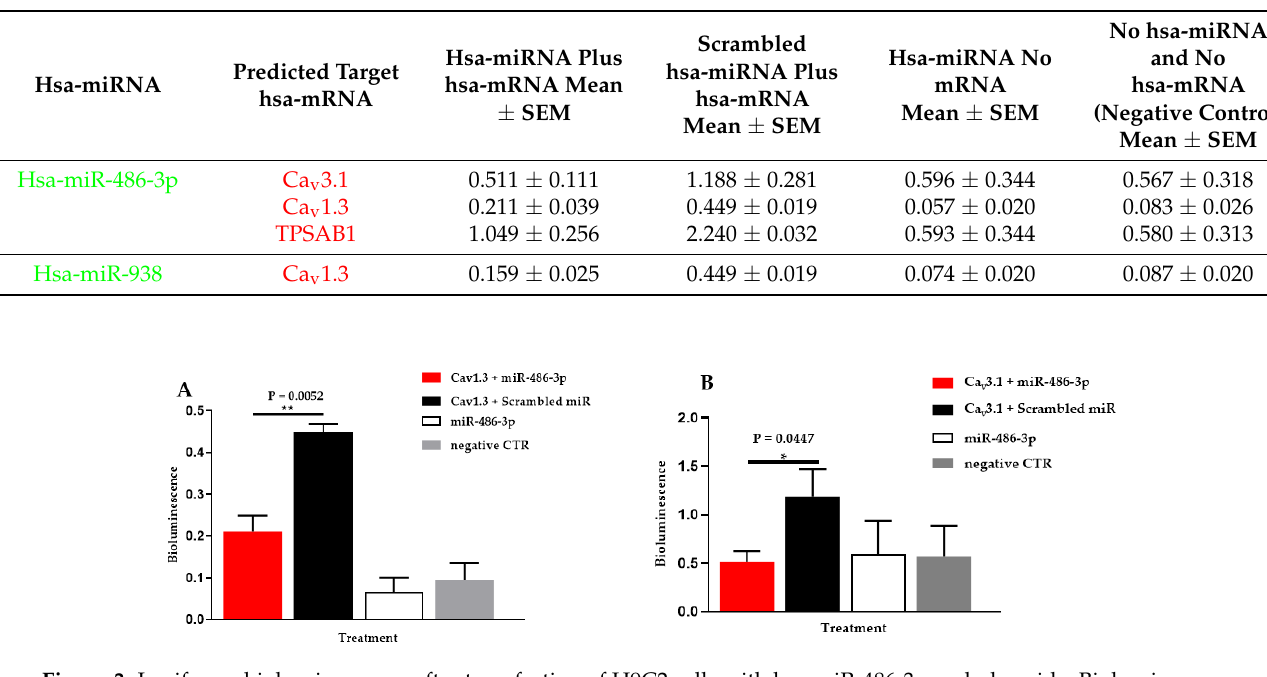
Figure 3. Luciferase bioluminescence after transfection of H9C2 cells with hsa-miR-486-3p and plasmids. Bioluminescence was recorded 24 h after transfecting H9C2 cells with 0.25 µg of ( A ) Ca v 1.3 ′ - or ( B ) Ca v 3.1—3 ′ -untranslated region-containing plasmid and 1.25 µL hsa-miR-486-3p or scrambled hsa-miRNA. Two control groups did not include the luciferase reporter gene, and cells were transfected with only hsa-miR-486-3p or remained untransfected (i.e., contained an equivalent volume of culture medium to replace the hsa-miRNAs or 3 ′ -untranslated region-containing plasmid). Data are shown as mean ± SEM ( n = 3 batches of experiments were plotted for Ca v 1.3; n = 6 batches of experiments were plotted for Ca v 3.1; * p ≤ 0.05, ** p ≤ 0.005).